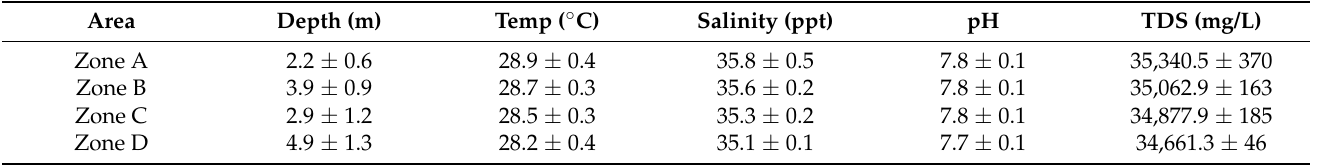
Table 1. Environmental factors in the four zones in the subtidal area of Gazi Bay (mean ±